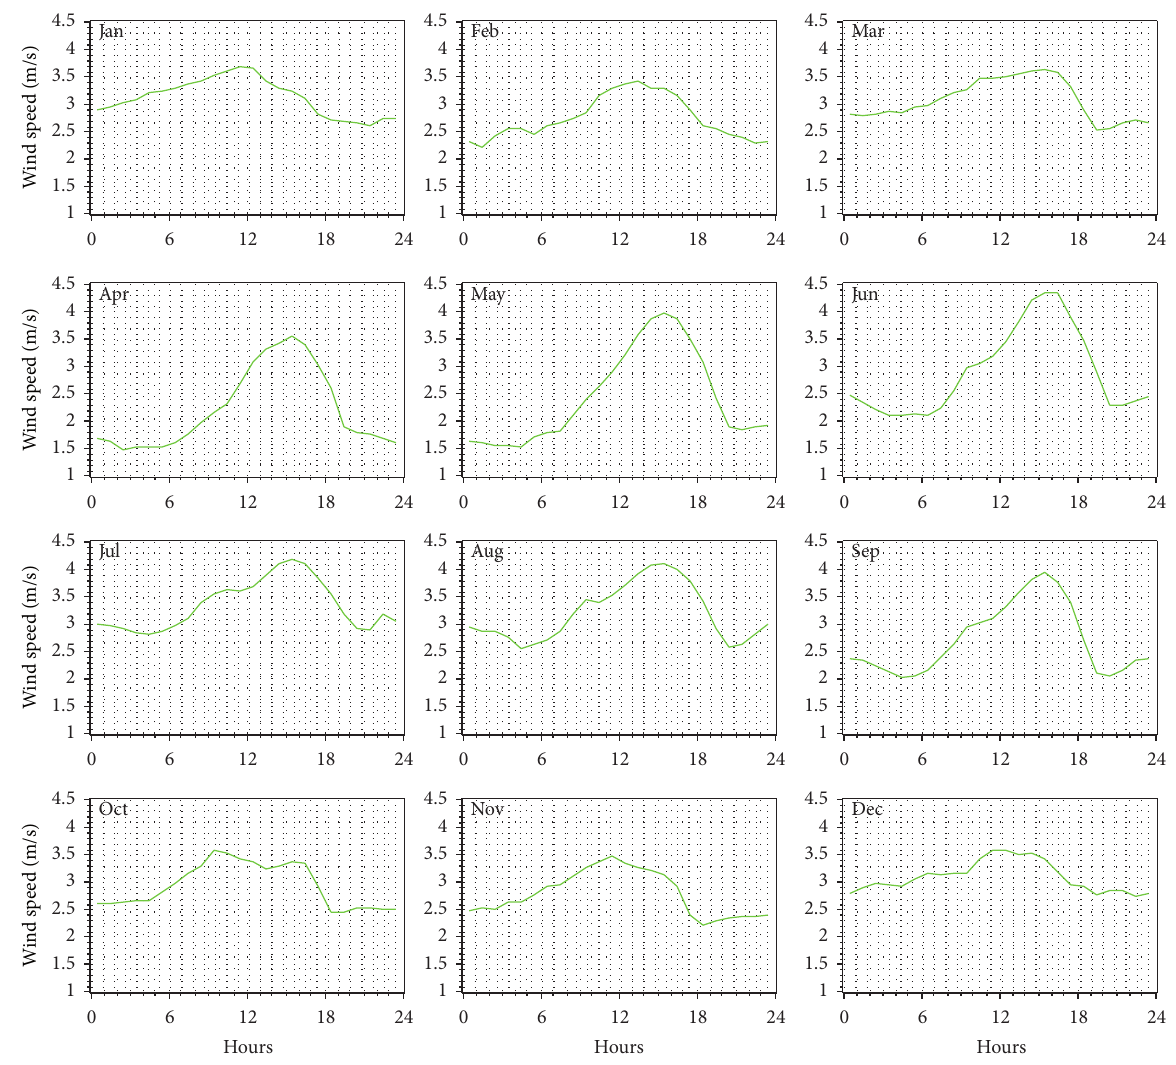
Figure 5: Hourly average of wind speed data for the 12 months of the